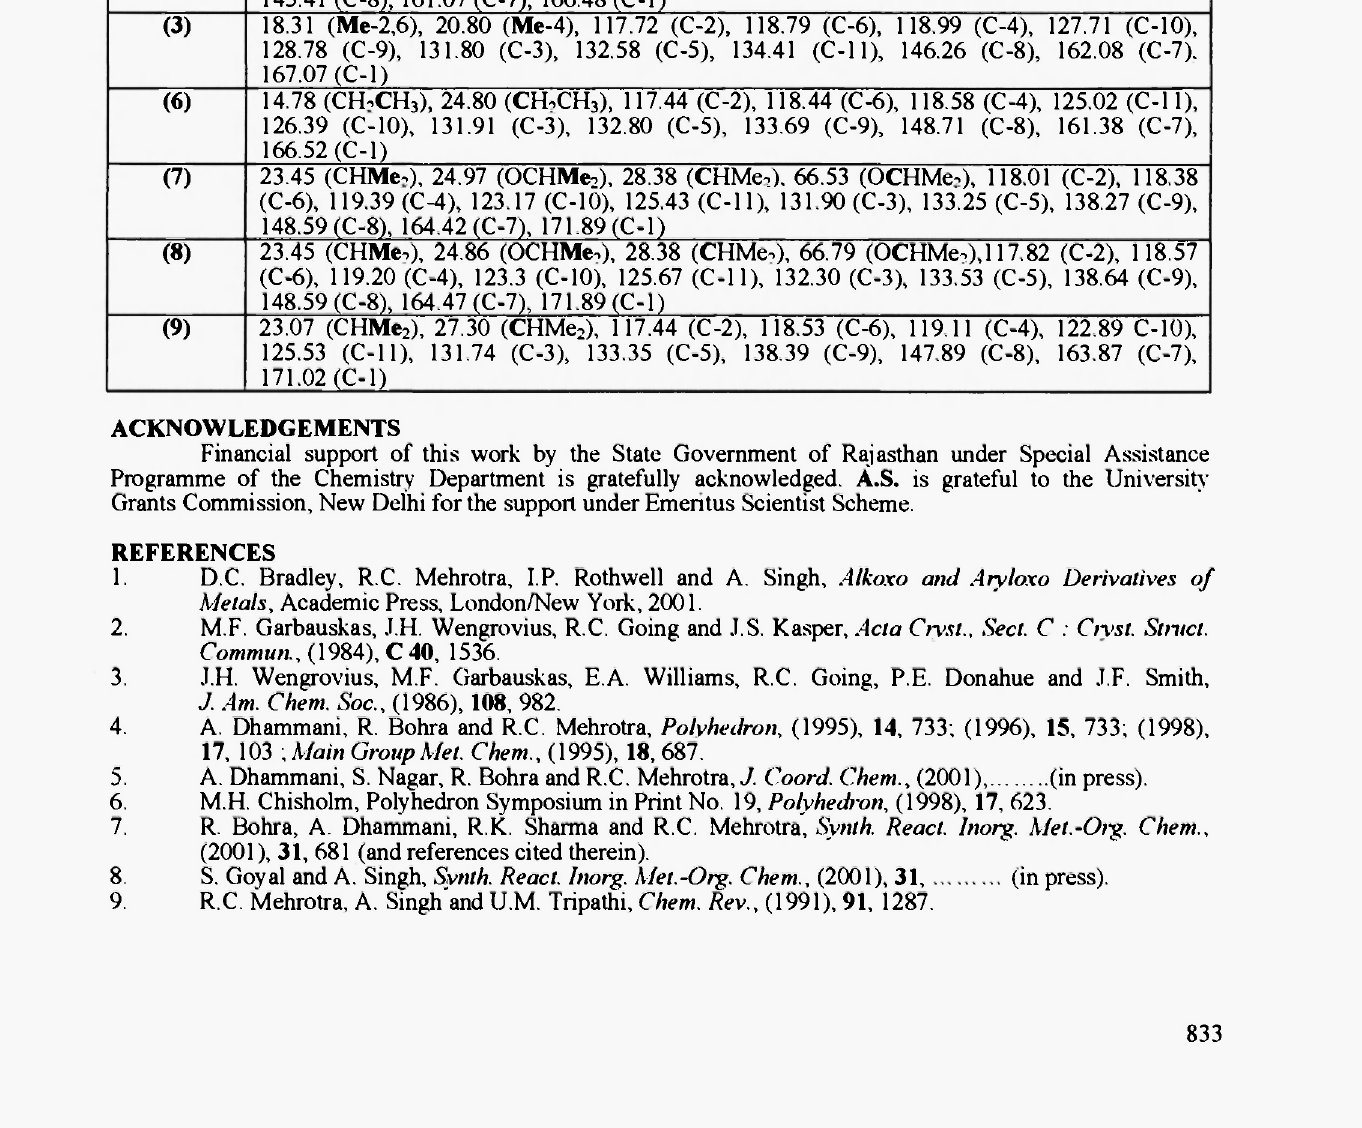
Table III. "C NMR Spectral Data (δ, ppm) for the New Compounds (1), (3), (6)-(9).